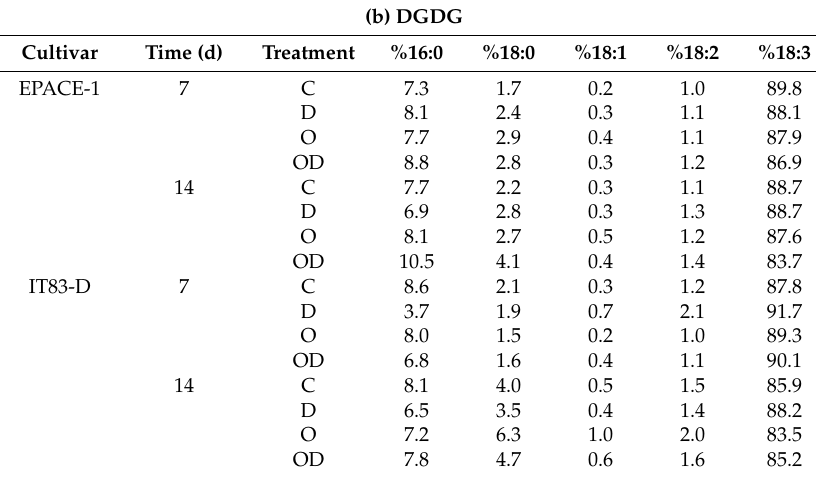
Table A2. Analysis of variance (ANOVA) of physiological parameters. The displayed results are p -values for individual factors (time, cultivar, drought and ozone) and their multiple interactions. Values in bold are significant at α = 0.05. SDW, shoot dry weight; g s , stomatal conductance; RWC,